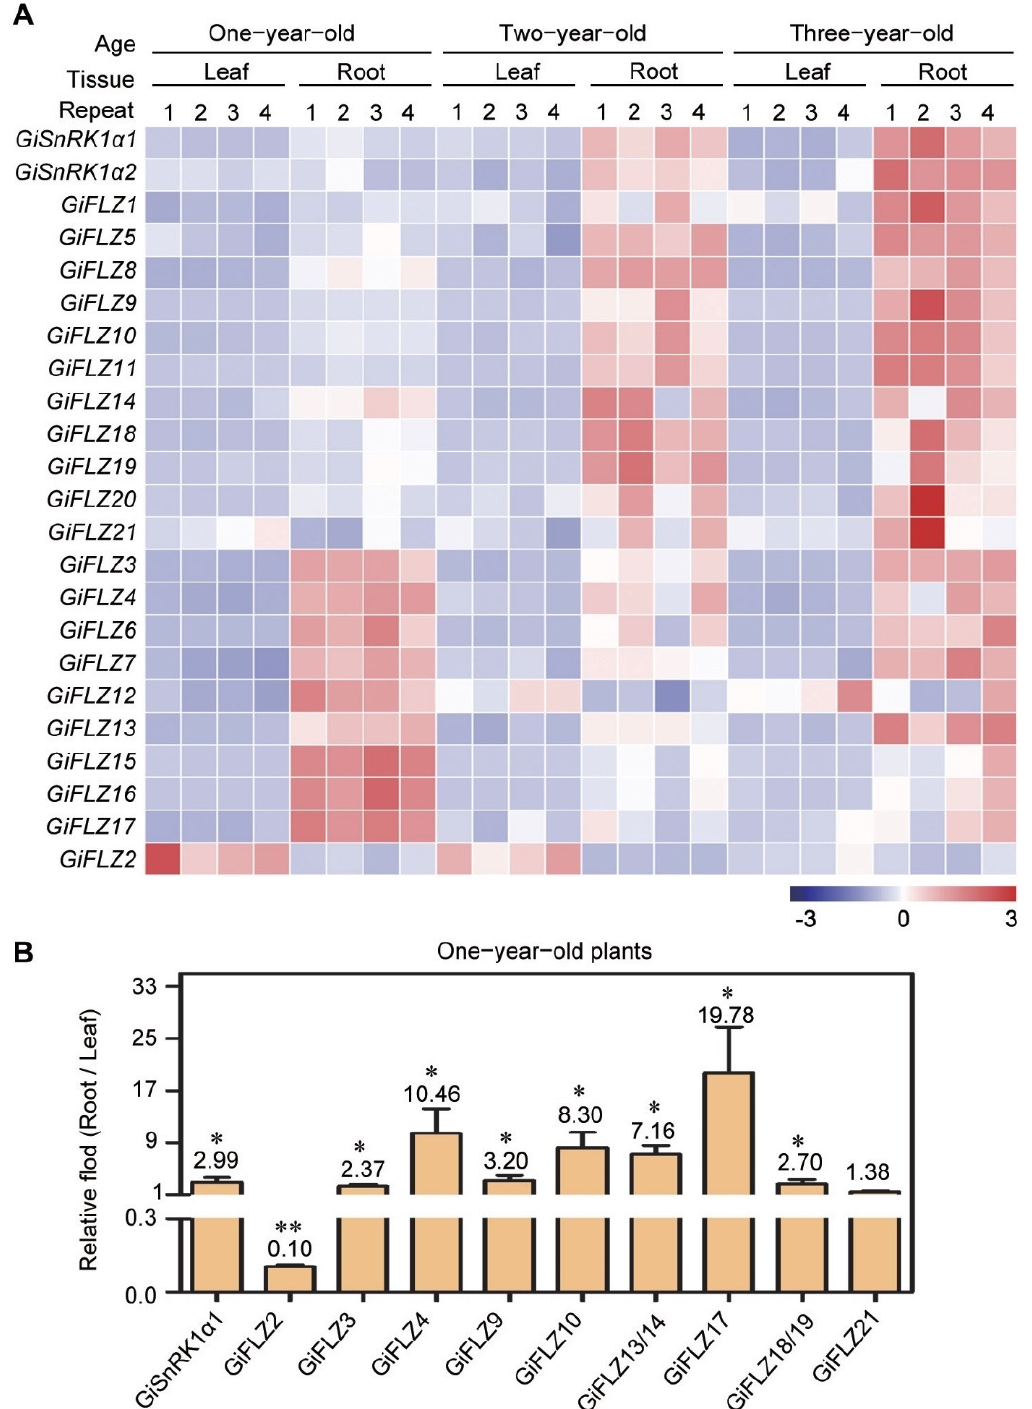
Figure 7. Expression pattern of GiSnRK1 α and GiFLZ genes in roots and leaves. ( A ) Heat map of the gene expression of GiSnRK1 α and GiFLZ in roots and leaves from different G. inflata plants of different ages. Data were normalized by taking a 2-based log of FPKM, shown from low (blue) to high (red) for each gene. ( B ) Tissue-specific expression of selected GiSnRK1 α and GiFLZ genes by qRT-PCR assay. The relative expression from root to leaf is presented as mean ± SD ( n = 3), and the data on the graph indicate the ratios. * p < 0.05; ** p < 0.01—determined by Student’s t-